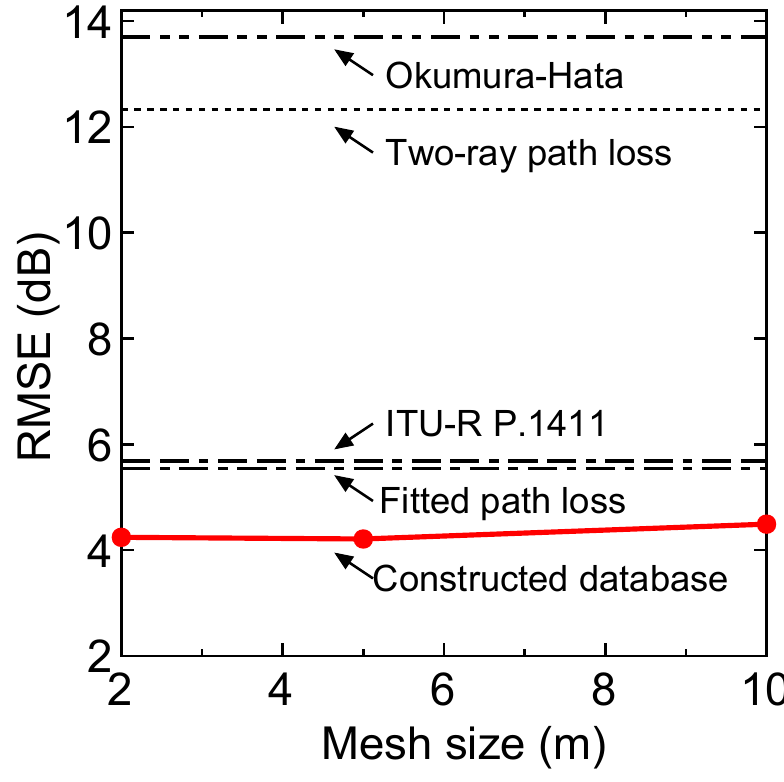
Figure 10. Mesh size versus